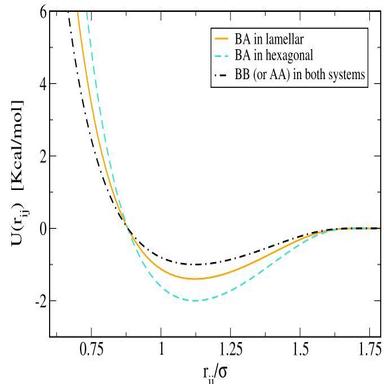
This figure shows the pair interaction energy curves of the studied model for different types of particles, namely A and B. Notably, for distances smaller than 1, repulsive interactions are observed for all particle types. Of particular interest is the BA curve, which distinguishes between the lamellar and hexagonal systems, as well as the molar fraction. Overall, these curves provide valuable insights into the behavior of the studied model and its constituent particles.